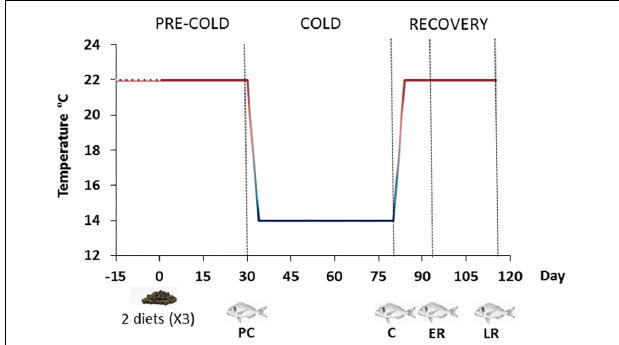
FIGURE 1 | Experimental design. Experimental period (115 days) consisted of four temperature periods: pre-cold (PC) at 22 ◦ C for 30 days; cold (C), during which the temperature was cooled to 14 ◦ C over five days and maintained for a total of 50 days (including the cooling down period); early recovery (ER), during which the temperature was restored to 22 ◦ C over 5 days and measurements were taken 1 week after the start of temperature recovery; and late recovery (LR), for which measurements were taken 35 days after the start of temperature recovery. Fish symbols indicate sampling